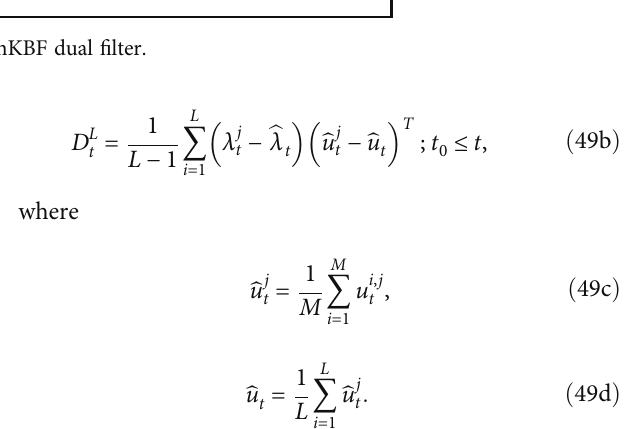
Algorithm 4 gives a summary of the KBF-EnKBF dual fi